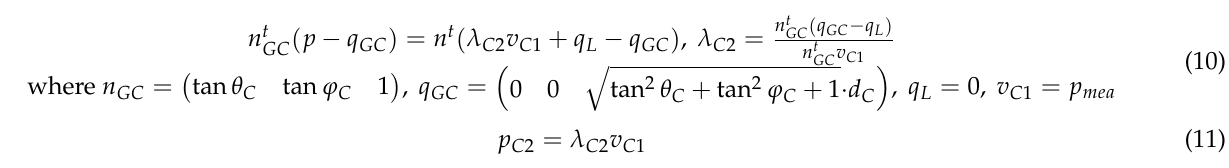
Figure 14. Plane Model.